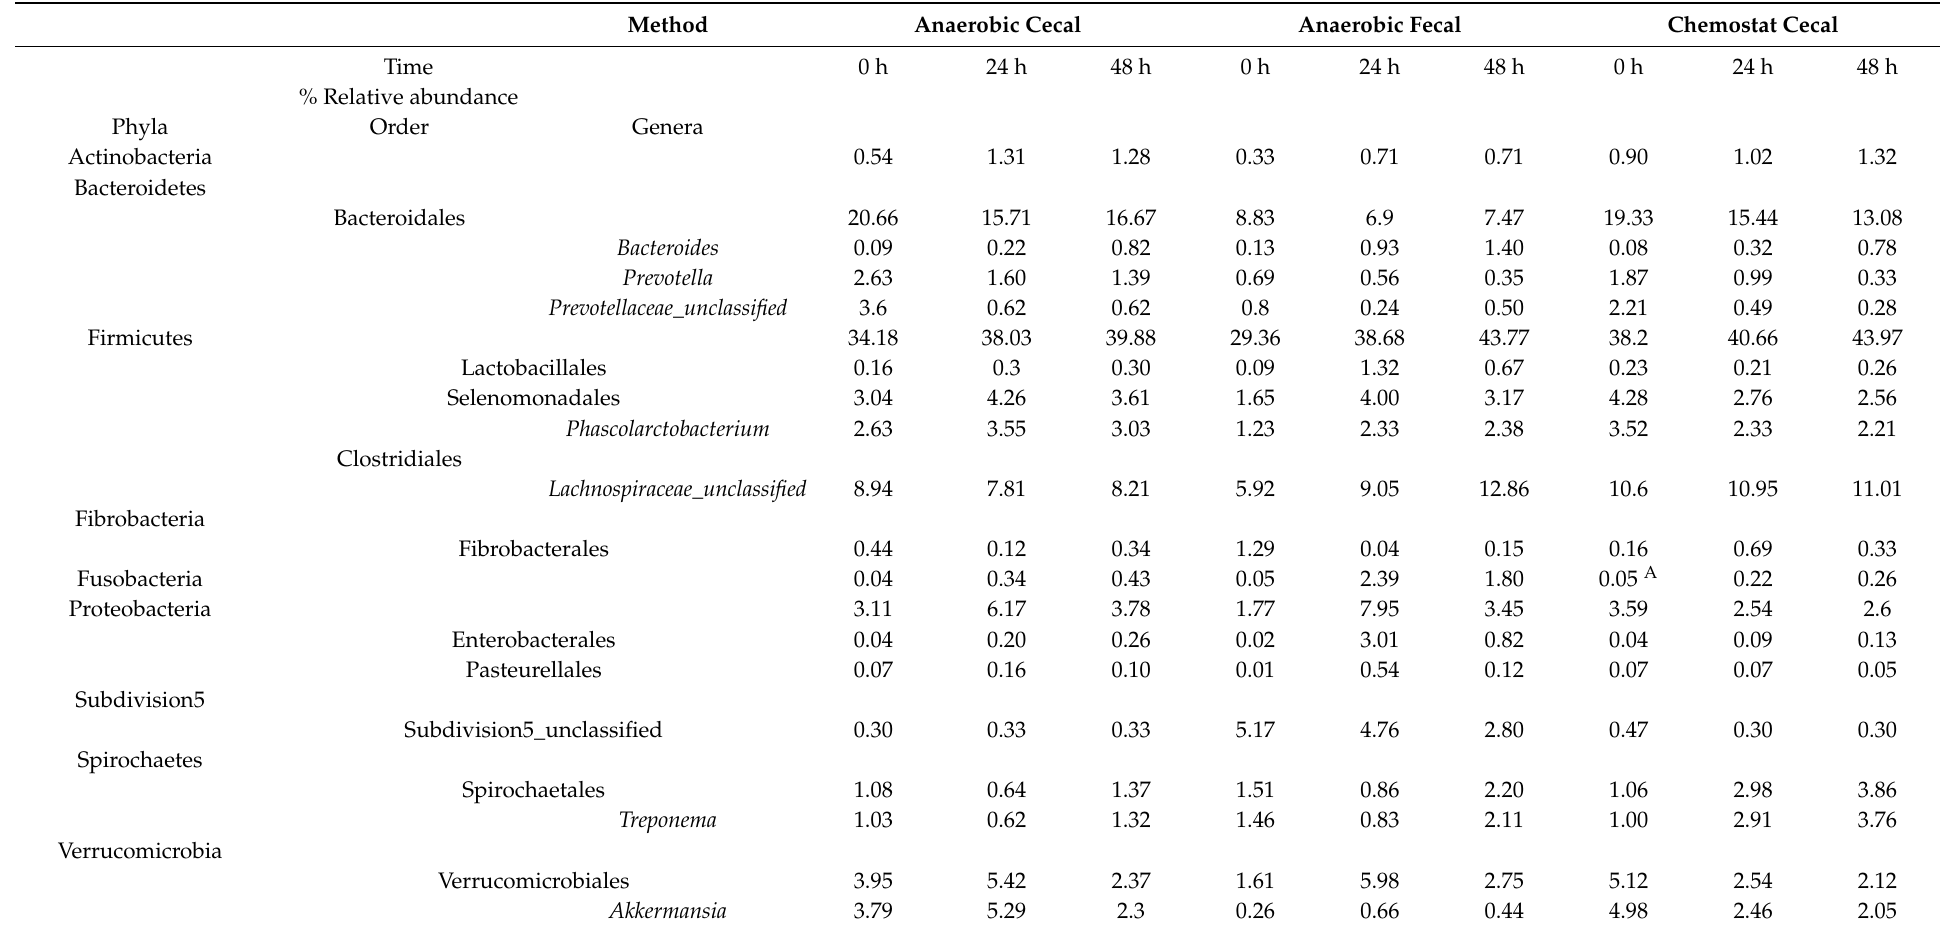
Table 1. Percent relative abundance of all phyla, order, and genera >1% that differ between inoculum types, cecal fluid fermentation methods, or between anaerobic chamber and chemostat